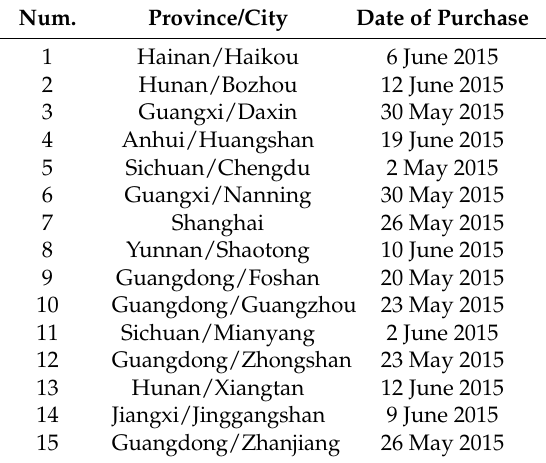
Table 10. The collection and descriptions of the tested samples.